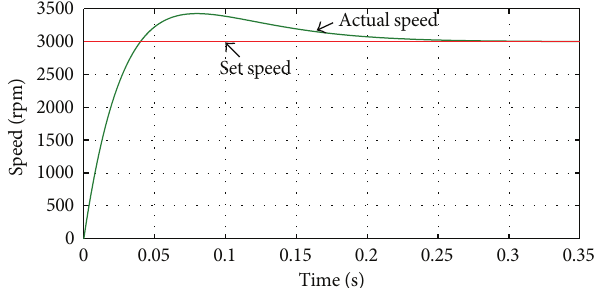
Figure 14: Simulated starting response of three-phase PMSM at no load and rated